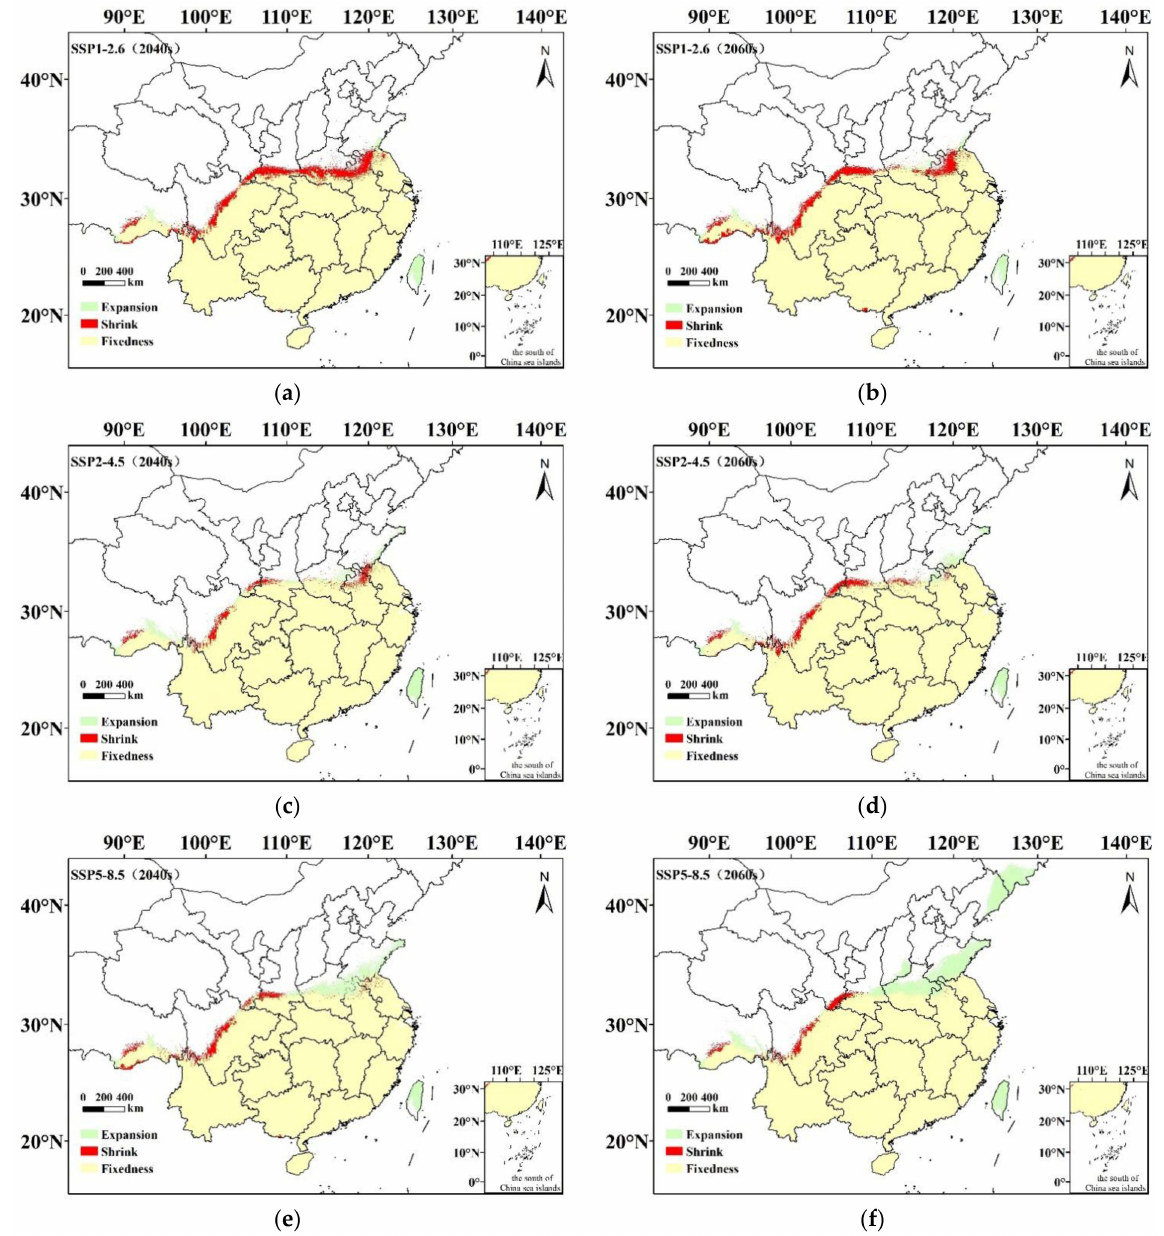
Figure 5. Spatial pattern change of suitable distribution for C. hystrix Miq. under future climatic conditions: ( a ). ssp1-2.6 (2040); ( b ). ssp1-1.6 (2040); ( c ). ssp2-4.5 (2040); ( d ). ssp2-4.5 (2060); ( e ). ssp5- 8.5 (2040); ( f ). ssp5-8.5